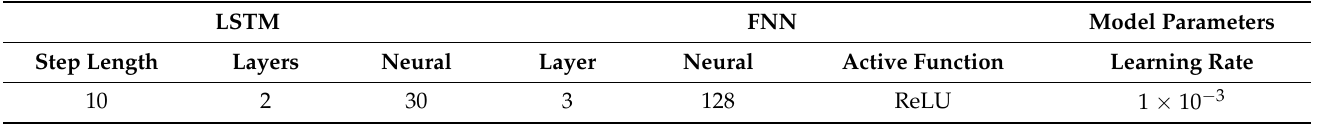
Model Parameters